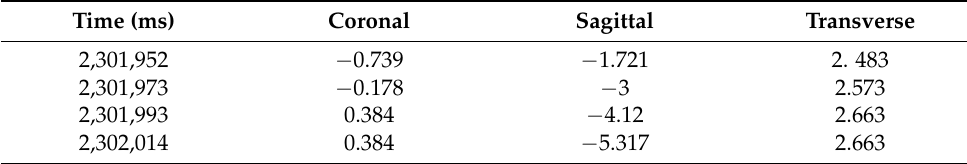
Table 1. Example of the measures reported by the ENLAZA inertial sensors.